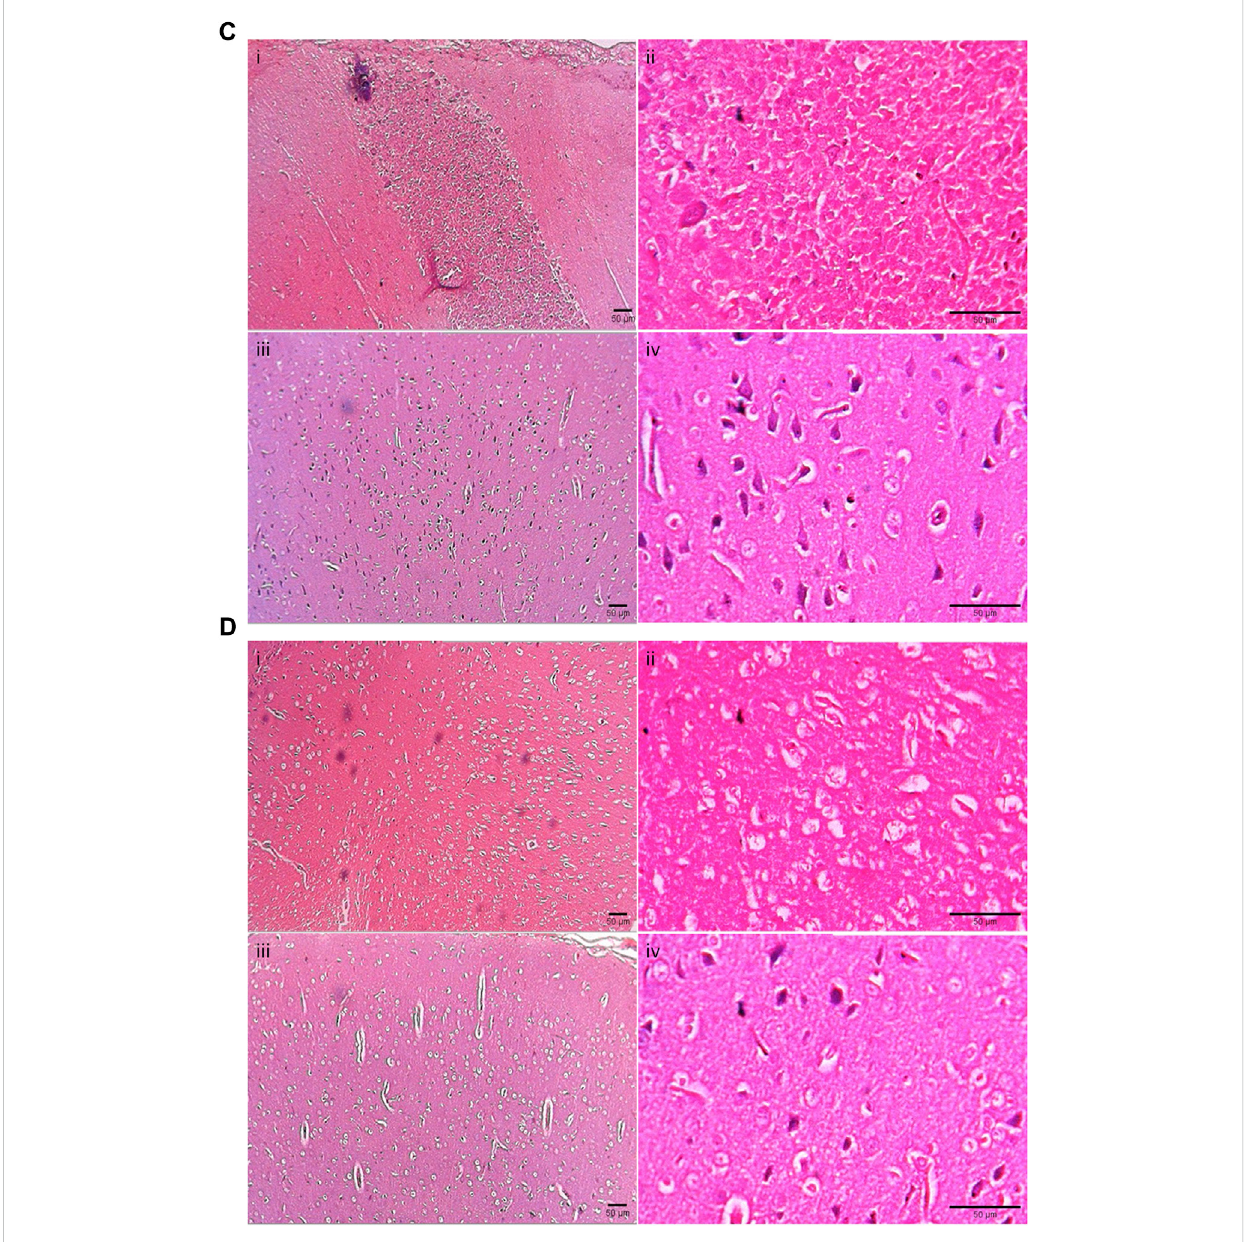
FIGURE 2 (Continued).PhotomicrographdepictingcerebralcorticesstainedwithhematoxylinandeosinofGroupsI,II,III,IV. (A) :Photomicrographofcerebral cortices stained with hematoxylin and eosin of Group I (control, Untreated + LCCAO) showing; i) Left (occluded) cerebral cortex (×10), ii) Left (occluded) cerebral cortex (×40), iii) Right (non-occluded) cerebral cortex (×10), iv) Right (non-occluded) cerebral cortex (×40). a - Pyknotic nuclei, b – red neurons with purkinje fi bre, c- mild lymphocytic in fi ltration, d - prominent stained nuclear component, e - multiple hazy nuclei with increased intercapsular space. (B) :PhotomicrographofcerebralcorticesstainedwithhematoxylinandeosinofGroupII( β -sitosterol+Sham)showing:i)Left(occluded)cerebral cortex (×10), ii) Left (occluded) cerebral cortex (×40), iii) Right (non-occluded) cerebral cortex (×10), iv) Right (non-occluded) cerebral cortex (×40). (C) : Photomicrograph of cerebral cortices stained with hematoxylin and eosin of Group III ( β -sitosterol + LCCAO) showing; i) Left (occluded) cerebral cortex (×10), ii) Left (occluded) cerebral cortex (×40), iii) Right (non-occluded) cerebral cortex (×10), iv) Right (non-occluded) cerebral cortex (×40). (D) : Photomicrograph of cerebral cortices stained with hematoxylin and eosin of Group IV (methanol extract + LCCAO) showing; i) Left (occluded)